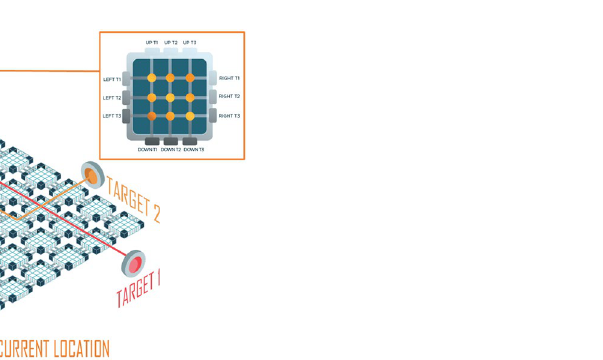
Figure 4. Simulation results of I.L via the numerial simultion method for 27 specific switching states as functions of the wavelength in 20-nm bandwidth when crosstalk is maintained lower than − 20 dB: (a) conceptual diagram with four groups of input/output ports I,J,K,O; (b) switching states from channels in the I group to the first channels in three remain groups; (c) switching states from channels in the I group to the second channels in three remaining groups; (d) switching states from channels in the I group to the third channels in three remain groups.